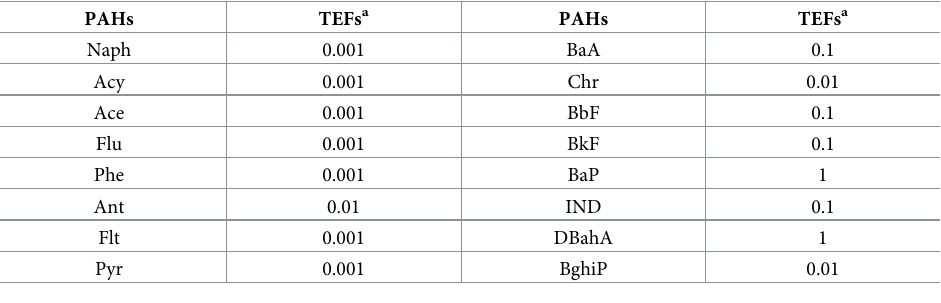
Table 2. TEFs used in calculating the carcinogenic potency. PAHs TEFs a PAHs TEFs a 0.001